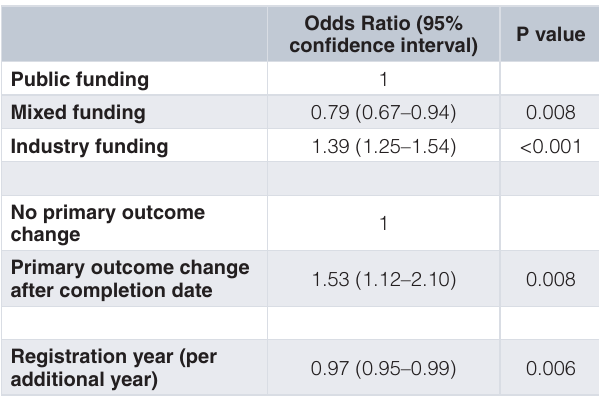
Table 1. Association of funding status and primary outcome change after trial completion with reporting a